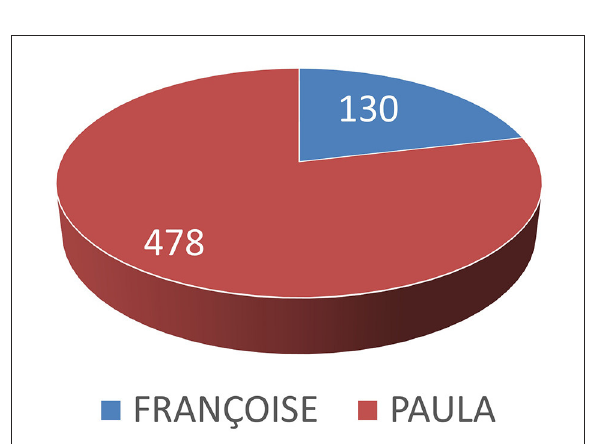
FIGURE4 Overall avatar preference. PAULA and FRANÇOISE were selected in 478 and 130 answers,